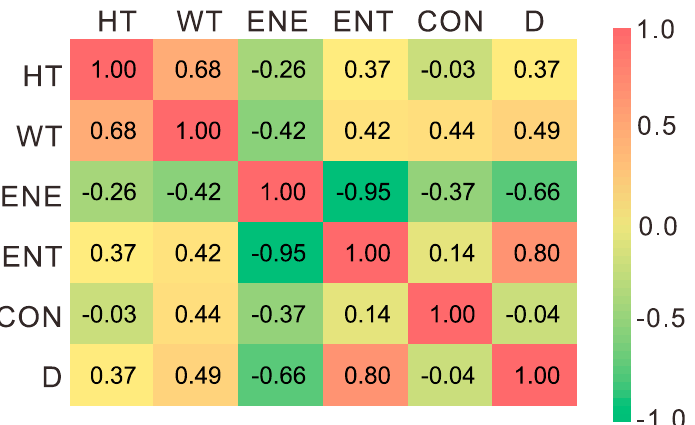
Figure 13. Pearson correlation coefficients matrix of different texture indicators.